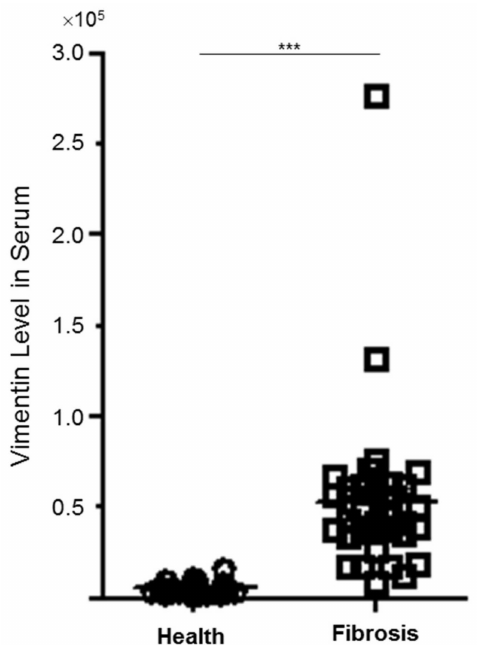
Figure 2. The quantitative results indicating the di ff erent levels of vimentin in clinical plasma specimens between normal control ( n = 22) and patients with hepatic fibrosis ( n = 33) (*** p <